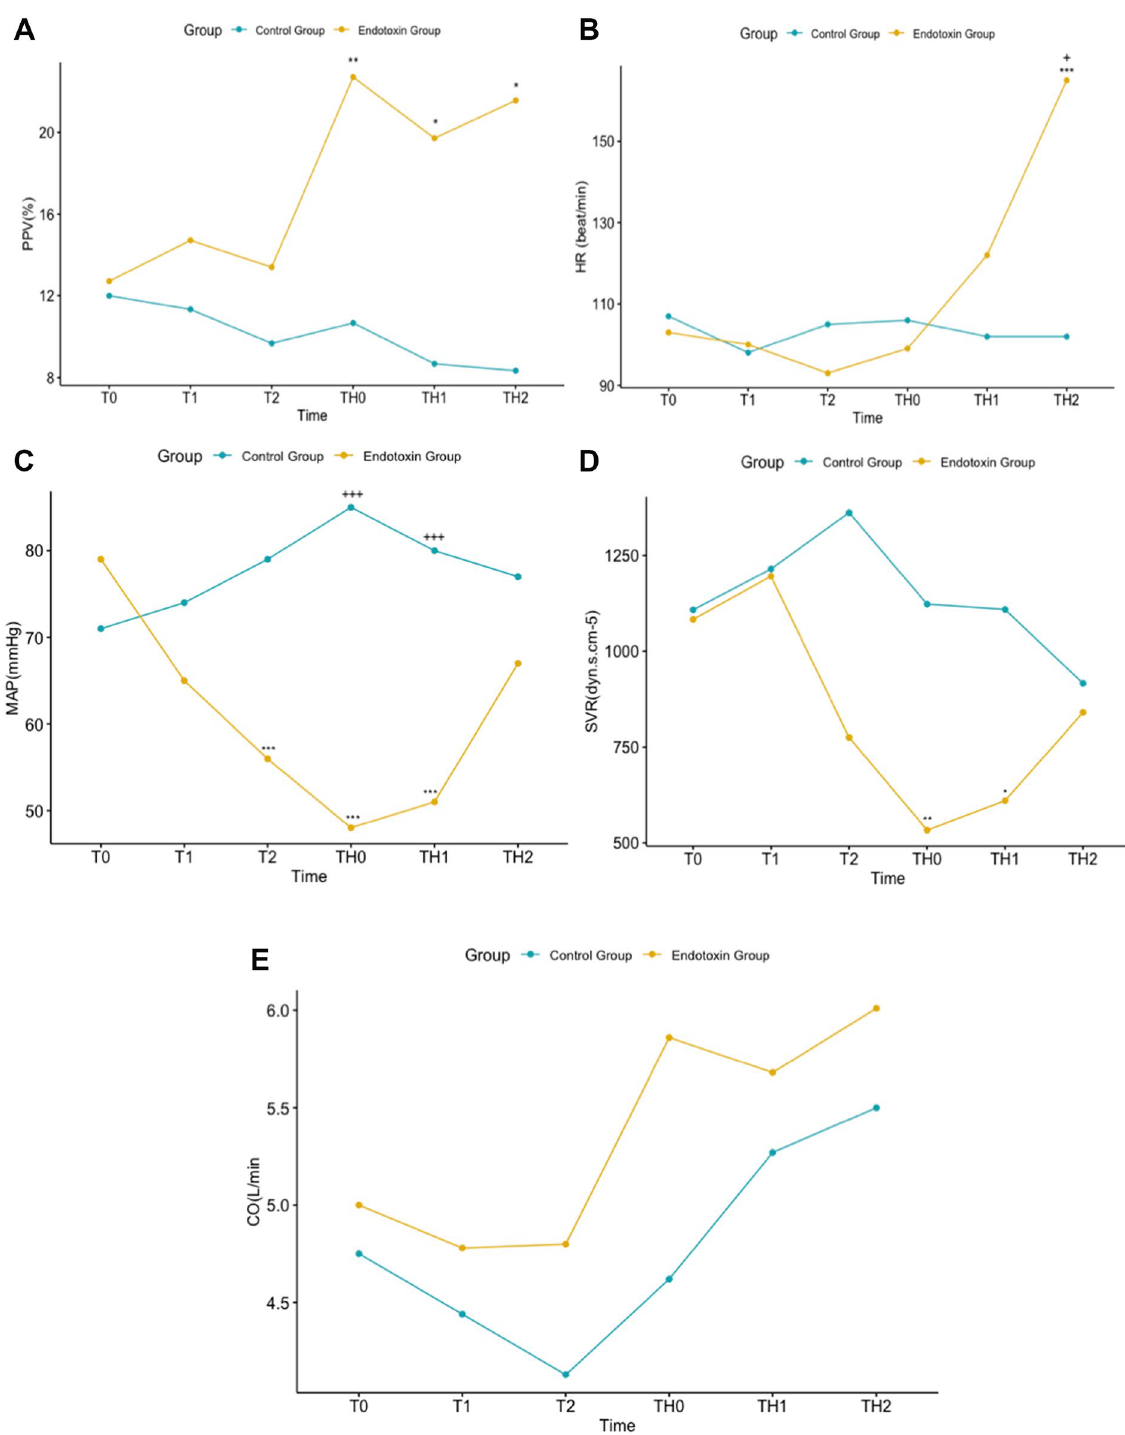
Figure 2. Changes of hemodynamic variables for 6 h of observation. ( A ) changes of pulse pressure variation (PPV); ( B ) changes of heart rate (HR); ( C ) changes of mean arterial pressure (MAP); ( D ) changes of systemic vascular resistance (SVR); ( E ) changes of cardiac output (CO). += p < 0.05, ++ = p < 0.01, +++ = p < 0.001 to comparison between Control and Endotoxin Group. *= p < 0.05, **= p < 0.01, ***= p < 0.001 to comparison between each time and T0 time on Endotoxin